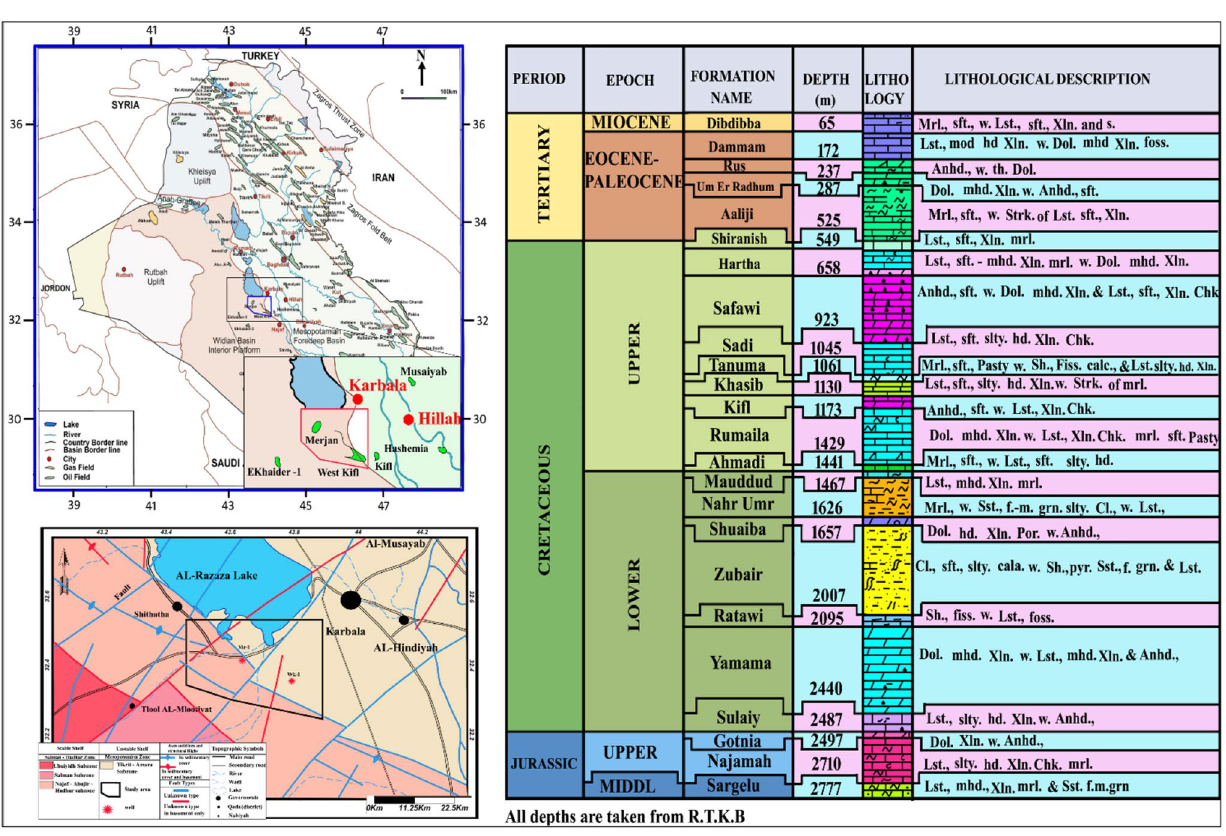
Fig. 1 a Location map (after Al-Ameri et al. 2014). b Tectonic map of a study area (after GEOSURV 1996) and c stratigraphic section of Me-1 well (after O.E.C.